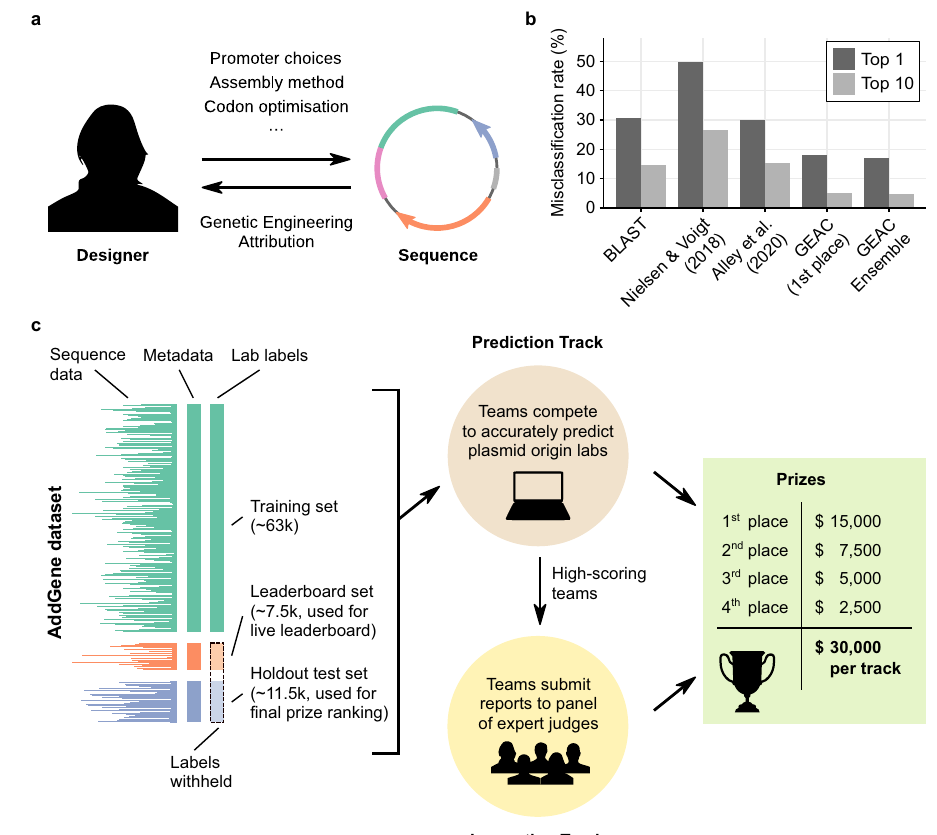
Fig. 1 | The Genetic Engineering Attribution Challenge. a The creation of any syntheticnucleic-acidsequenceinvolvesnumerousdesigndecisions,eachofwhich leavesamarkintheresultingsequence.Geneticengineeringattribution(GEA)aims to use these marks to identify the designer. b Misclassi fi cation rate (1-(Top-N accuracy)) of past ML approaches to GEA on the Addgene plasmid database, compared to BLAST (left) and the results of the Genetic Engineering Attribution Challenge(GEAC,right).Lowermisclassi fi cationratesindicatehigheraccuracy.Our BLAST method achieves higher accuracy than previous implementations; see